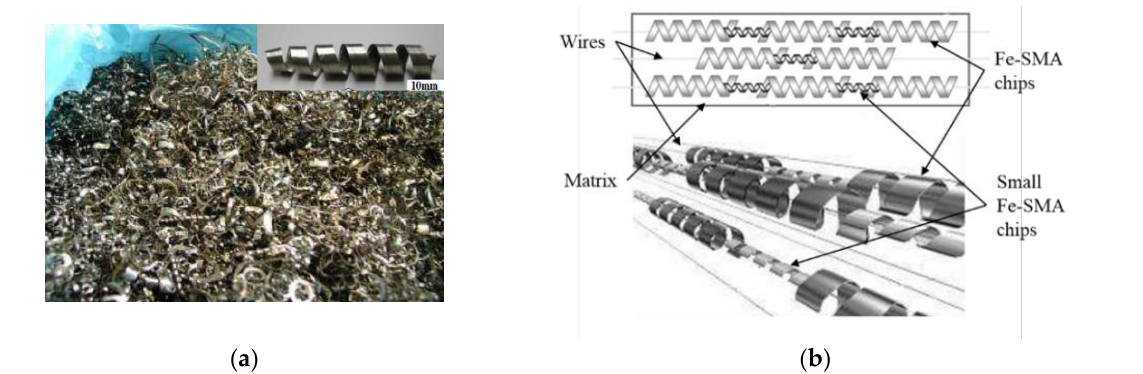
Figure 9. Fe-Mn-Si-Cr alloy chips for reinforced plaster matrix [111]: ( a ) Fe-SMA machining chips; ( b ) arrangement of Fe-SMA chips.